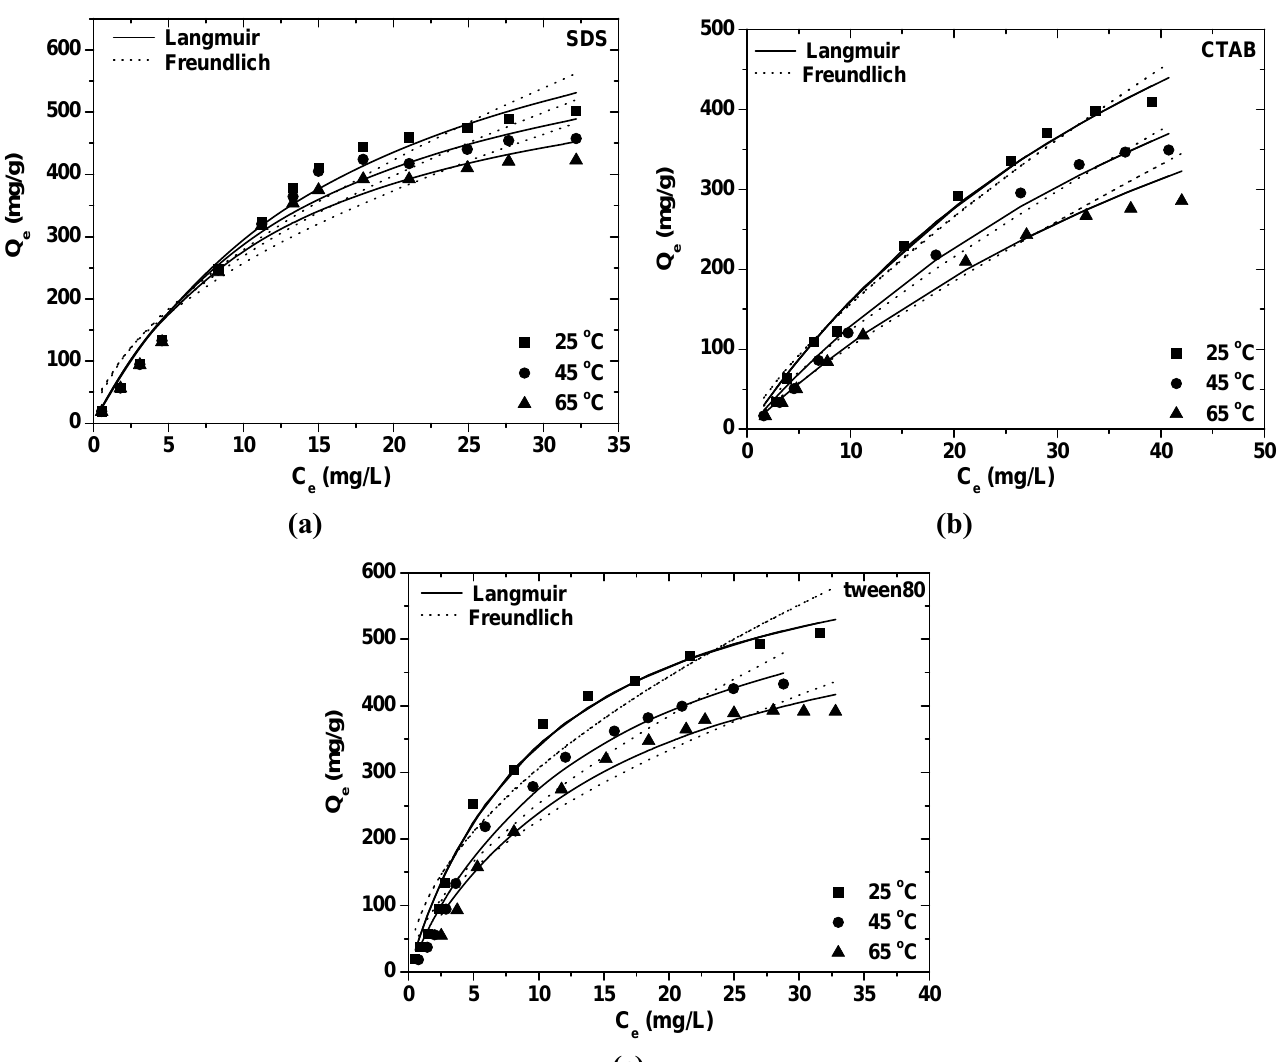
Figure 1. Adsorption isotherms of ( a ) sodium dodecyl sulphate (SDS); ( b ) cetyl trimethyl ammonium bromide (CTAB) and ( c ) tween80 at three different temperatures